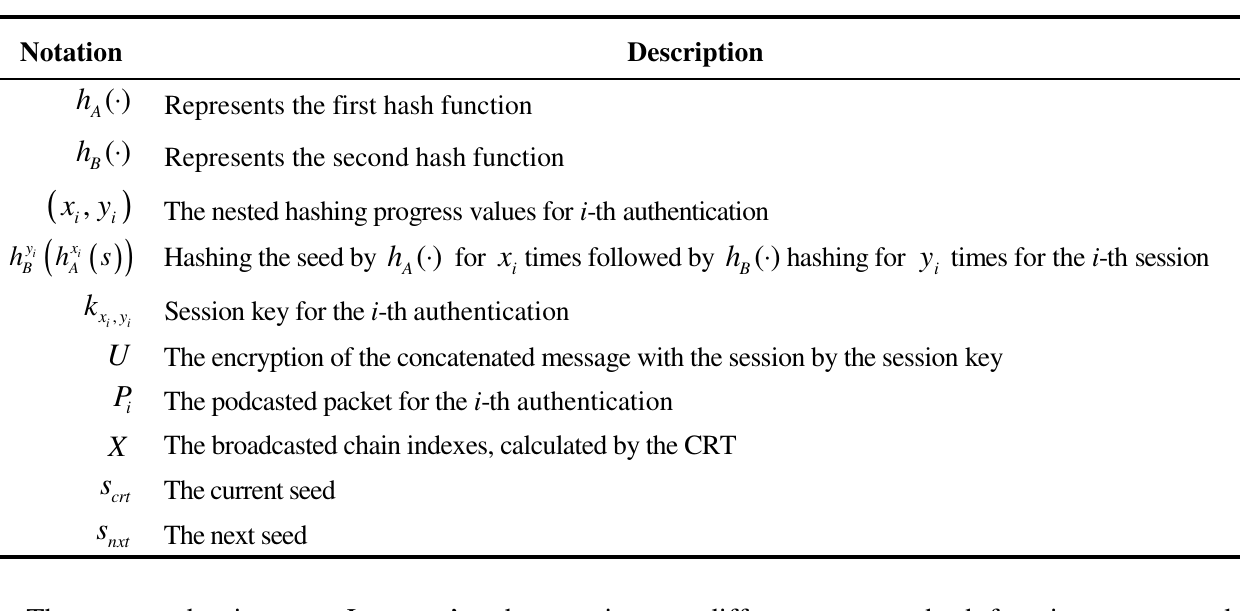
Table 1. The Proposed Scheme